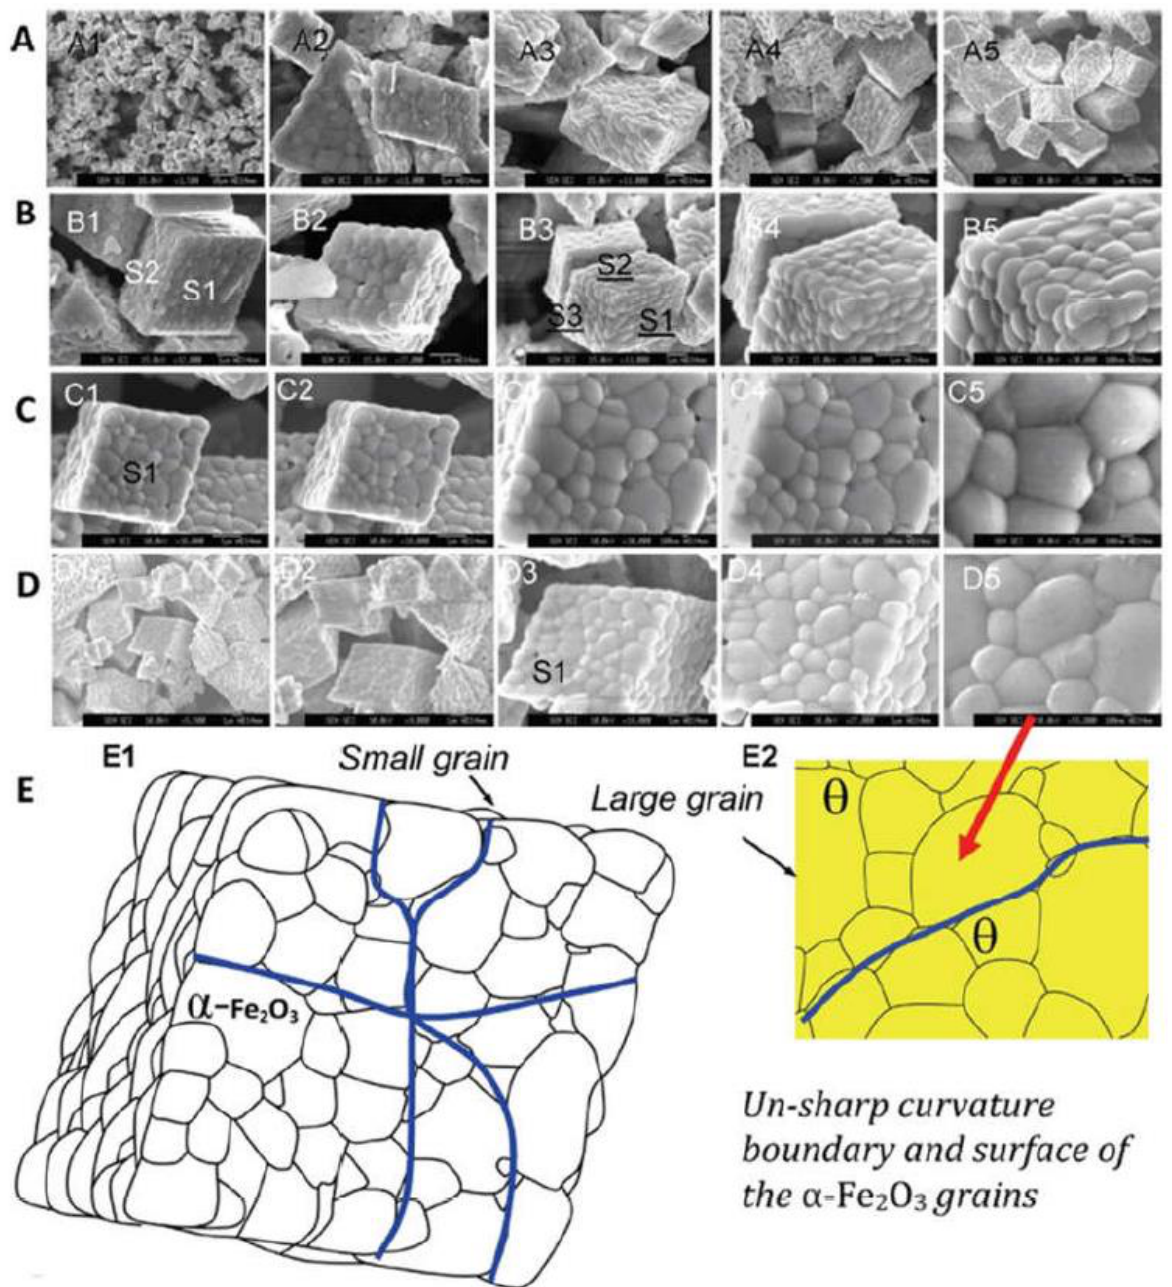
Figure 7. The evidences of α -Fe 2 O 3 oxide micro/nanostructures with grain and grain boundary are a challenge to science [49]. ( A – E ) The surfaces of -Fe 2 O 3 particles with grain and grain boundary. To develop inexpensive catalytic and magnetic particles, typically such as Fe, Ni, Co, and their alloys possibly used at the electrodes of FCs, the researchers have very success- fully developed large magnetic PVP-Fe- based particles in the size range of 5 and 10 μm with polyhedral or spherical shapes and morphologies that led to produce various kinds of iron oxide nanostructures with potential applications for the electrodes of batteries in energy conversion, gas sensors, and the environment as well as devices using soft mag- netic materials. In simplification approach, Fe oxide and alloy microsystems can be syn- thesized by chemical methods and heat treatment, which leads to produce various kinds of oxides, alloys, superalloys, micro/nanosized particles, etc., which can use inexpensive core materials. The various kinds of normal and inverse spinel ferrite particles with